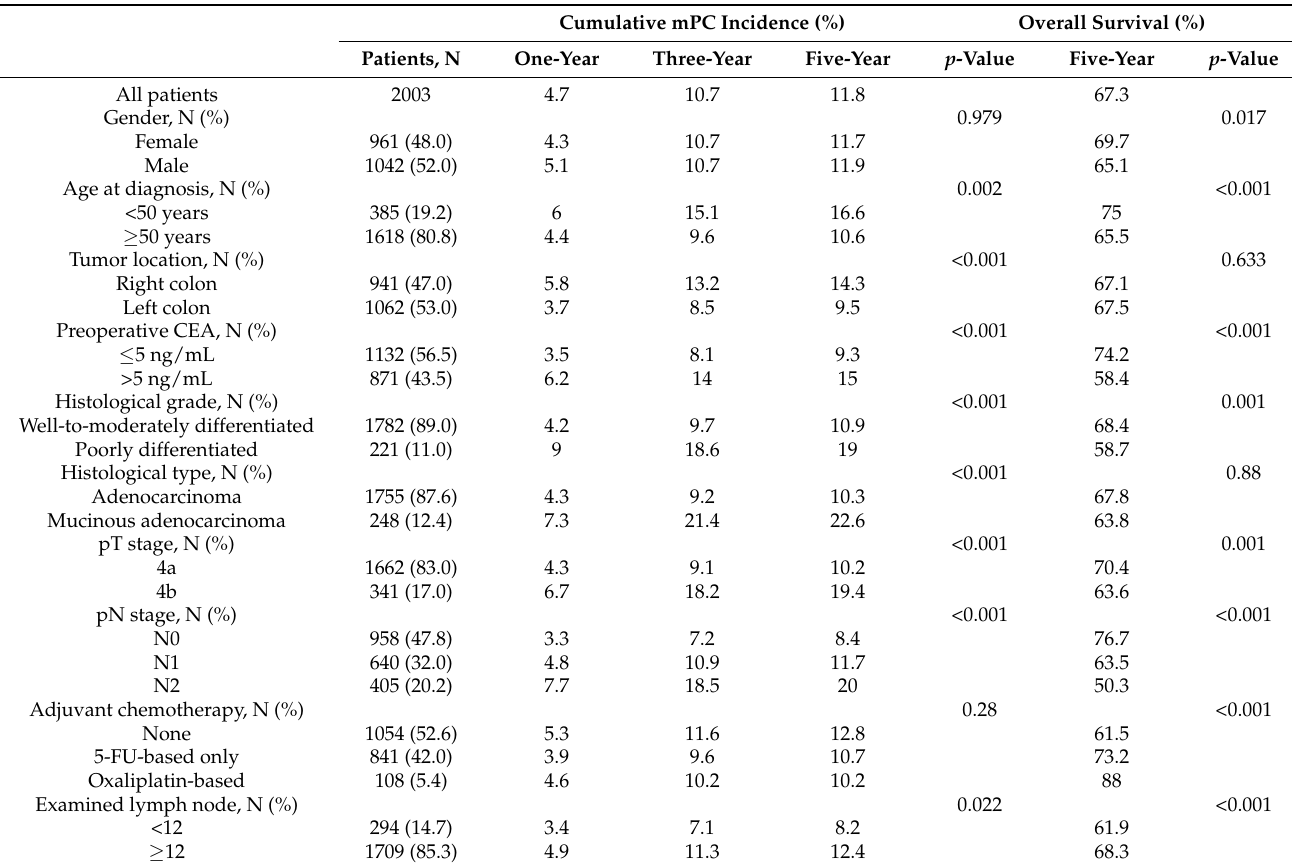
Table 1. Cumulative mPC incidence and five-year overall survival of 2003 patients with pT4 colon cancer after curative resection. Cumulative mPC Incidence (%) Overall Survival (%) Patients, N One-Year Three-Year Five-Year p -Value Five-Year p -Value All